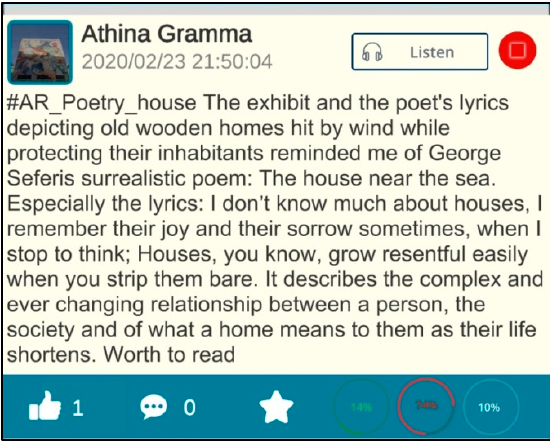
Figure 14. ARtful’s gamification badges awarded to users for intense participating activity and popularity.